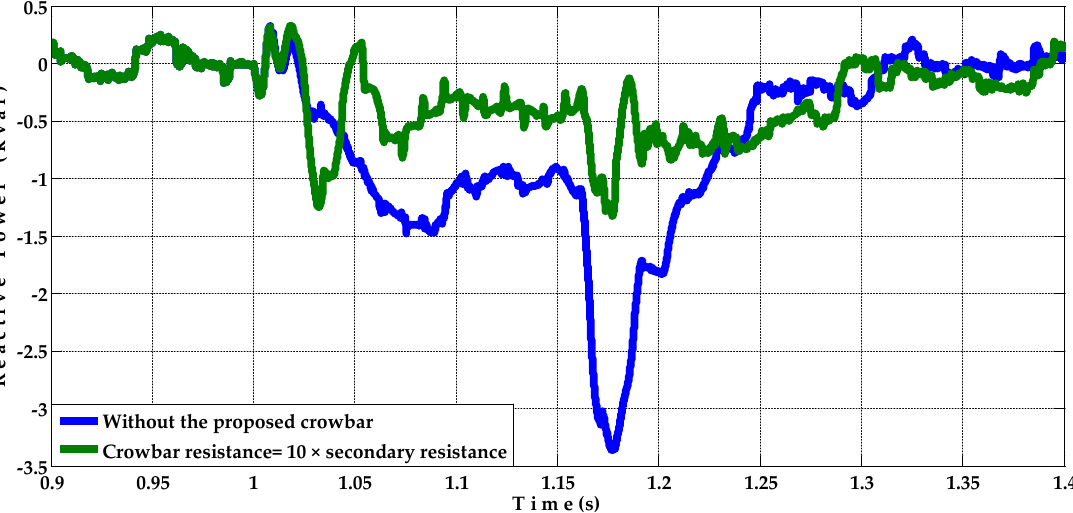
Figure 23. Reactive power of BDFRG with and without the proposed crowbar under line-to-line fault occurrence.